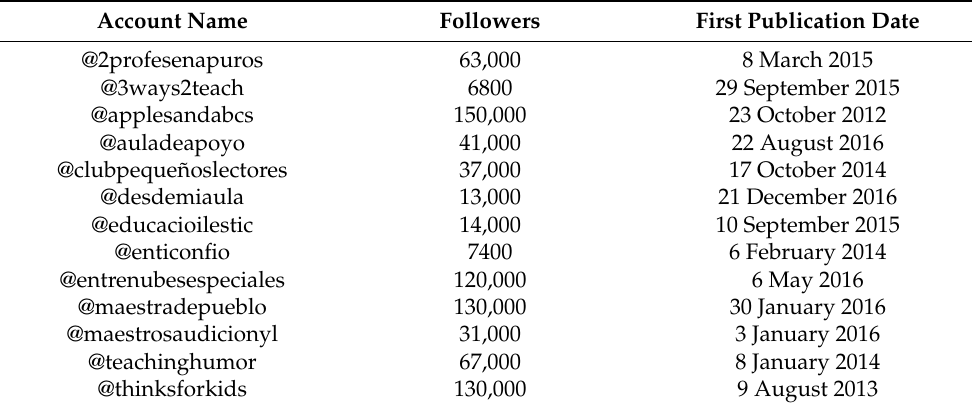
Table 2. Research